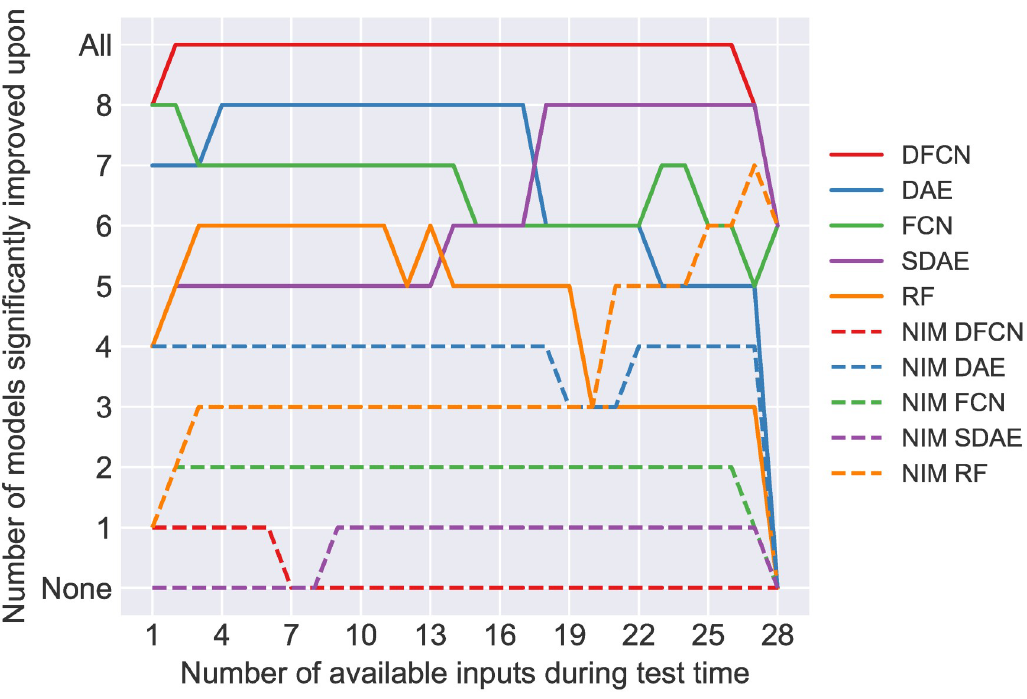
the same y value are statistically equal in performance).